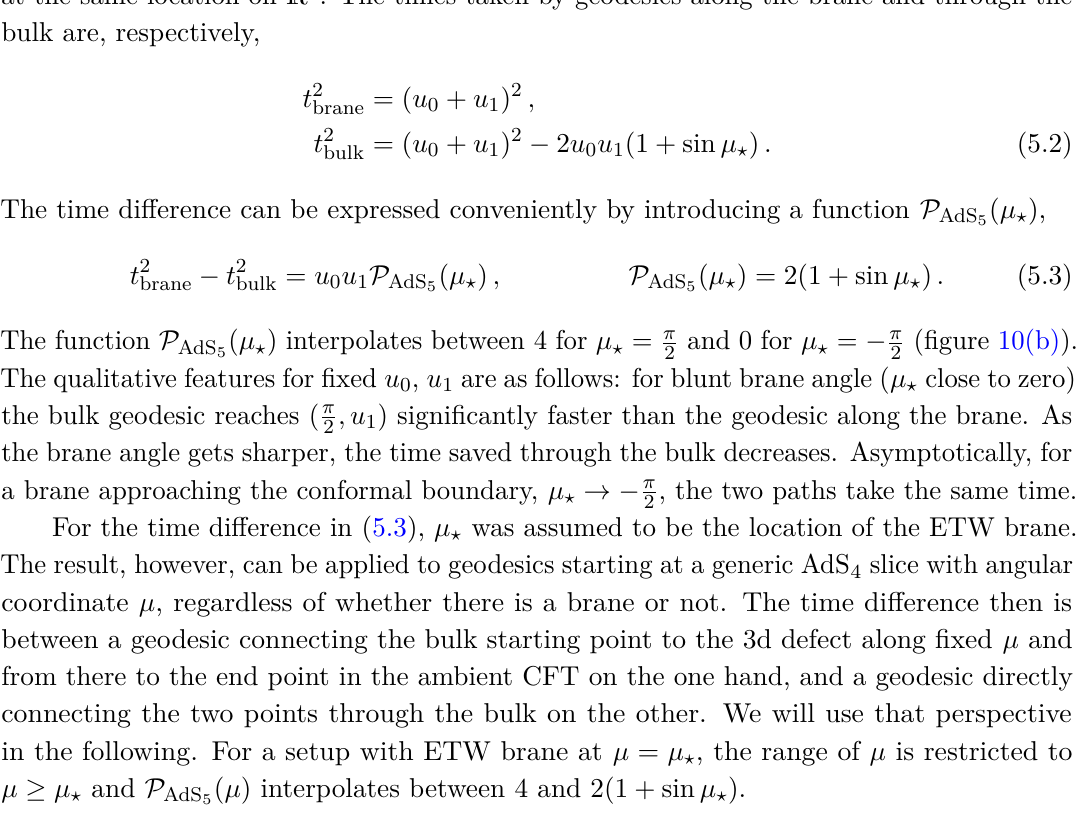
( µ ) defined in (5.3). 5 ≤ 0 . The region µ < µ is cut off and the remaining ? ? (figure 10(a)). The geodesics of interest connect 2